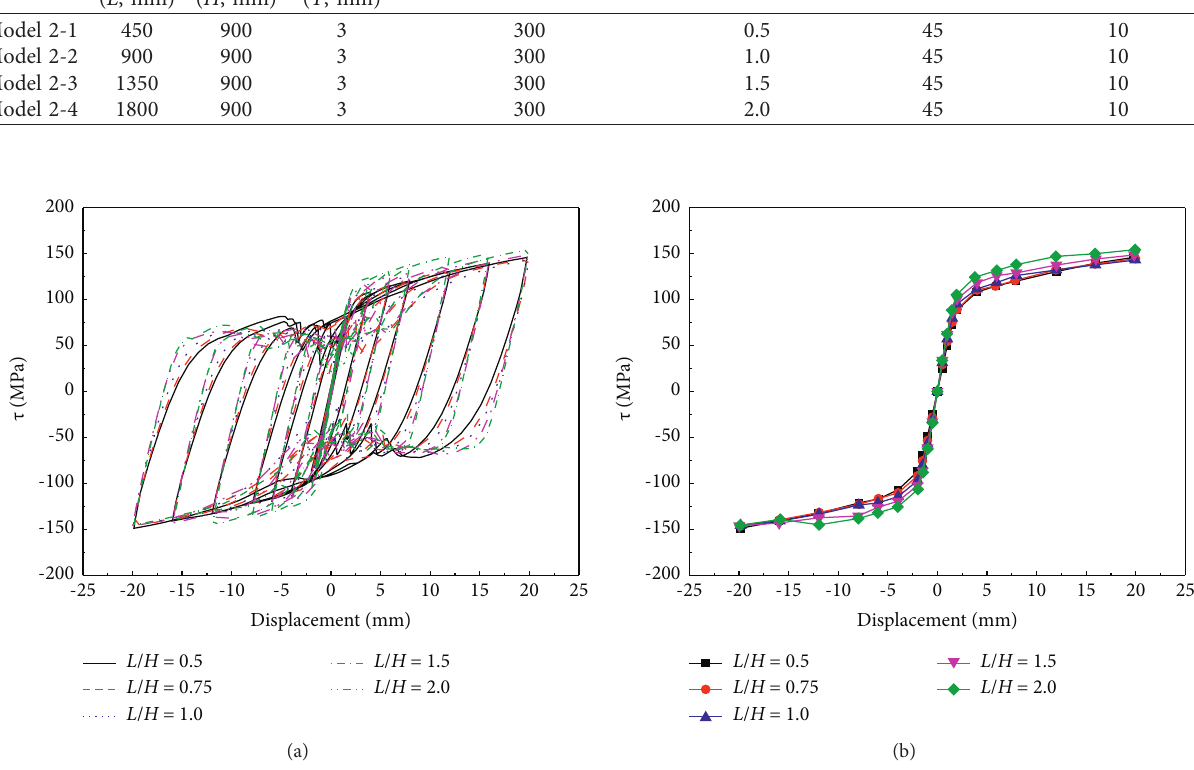
Figure 23: The effect of aspect ratio. (a) Hysteretic curves. (b) Skeleton